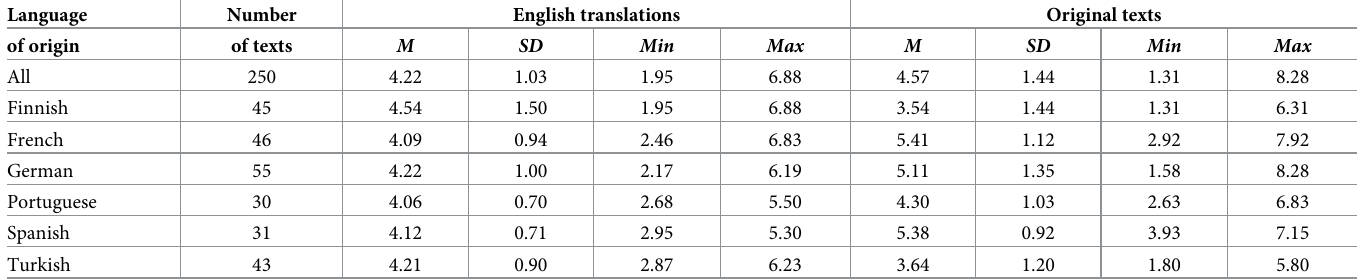
Table 5. Means, standard deviations, and minimum and maximum arousal ratings for all texts, separately for the English translations and the original language versions. Language